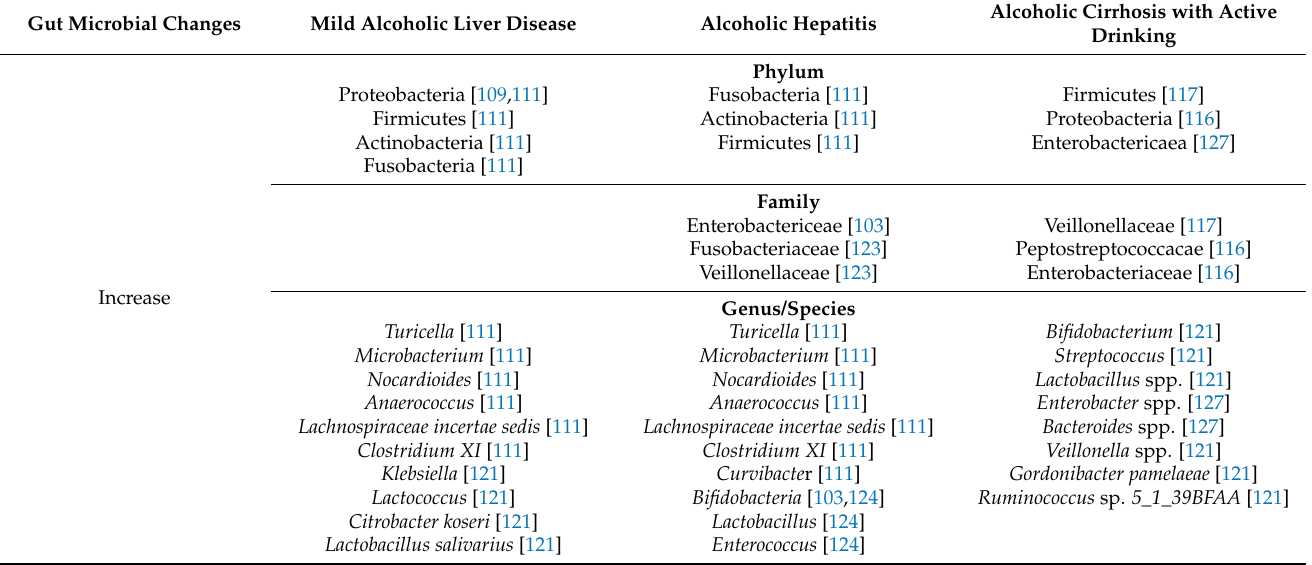
Table 3. Gut dysbiosis profiles in alcoholic liver